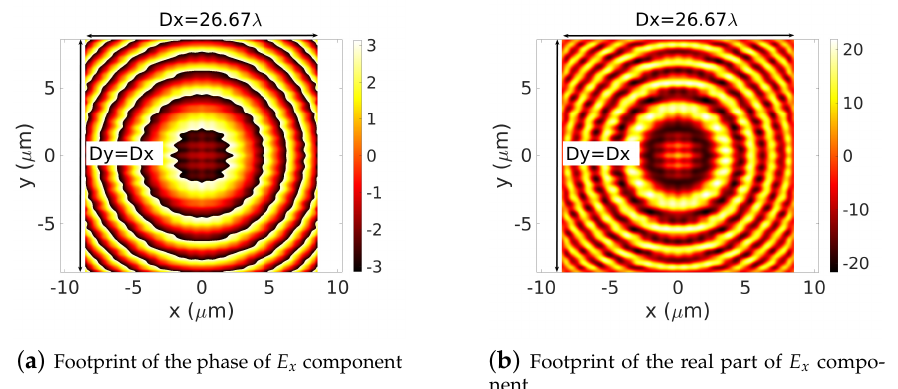
Figure 5. Footprints of the phase ( a ) and the real part ( b ) of an E x electric dipole on the plane z = − 20 λ . The numerical computation is performed on the whole domain [ − 0.5 D x ,0.5 D x ] × [ − 0.5 D y ,0.5 D y ] . The operating wavelength: λ = 0.64 µ m, D x = D y = 26.67 λ , truncation orders M x = M y =